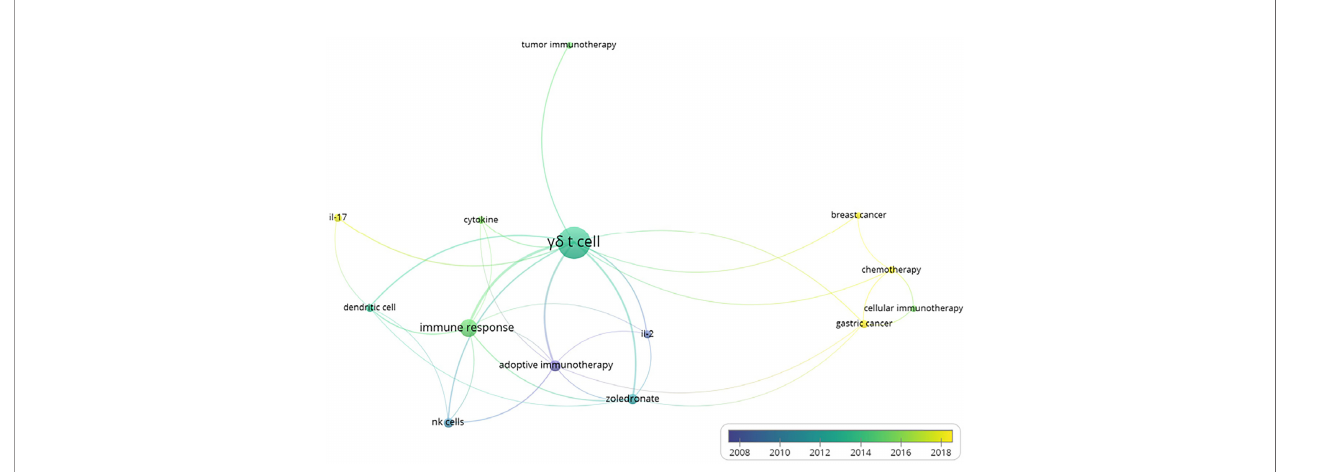
FIGURE 2 | Overlay visualization map of author keywords co-occurrence analysis. Map shows that gd T cells mediated immune responses. Of all investigated cancers, gastric and breast cancers were most closely linked to gd T cells. Interleukin (IL)-17 and IL-2 were identi fi ed as the most common cytokines linked to gd T cells.